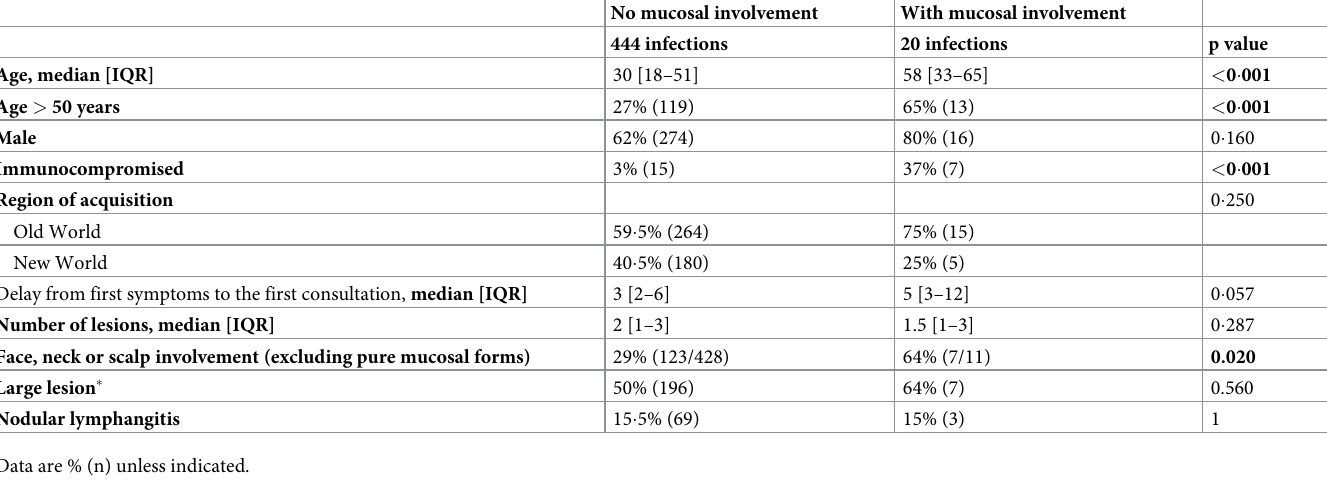
Table 3. Comparative features in patients with or without mucosal involvement at presentation.